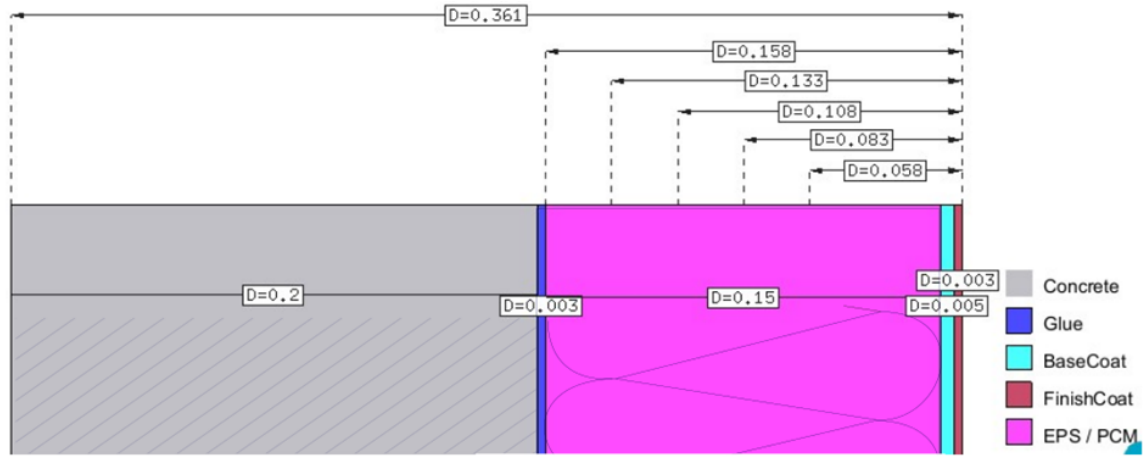
Figure 2. Individual layers of demonstration wall with the locations of temperature monitoring points (dimensions in